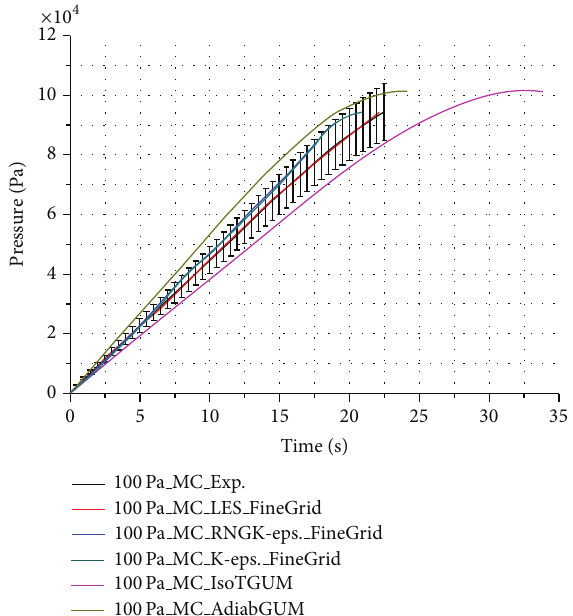
Figure 28: Average pressure time trend for different turbulence models (100Pa, AC).